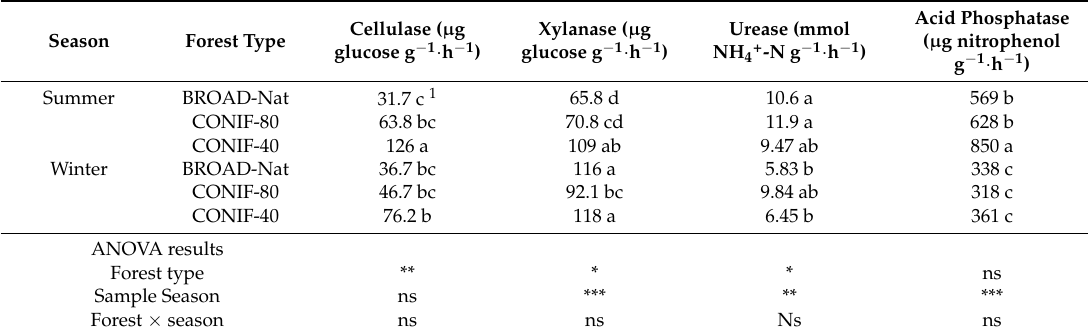
Table 3. Soil enzymatic activities in 40-year-old (CONIF-40) and 80-year-old (CONIF-80) coniferous forest plantations and a natural broadleaf forest (BROAD-Nat) in two